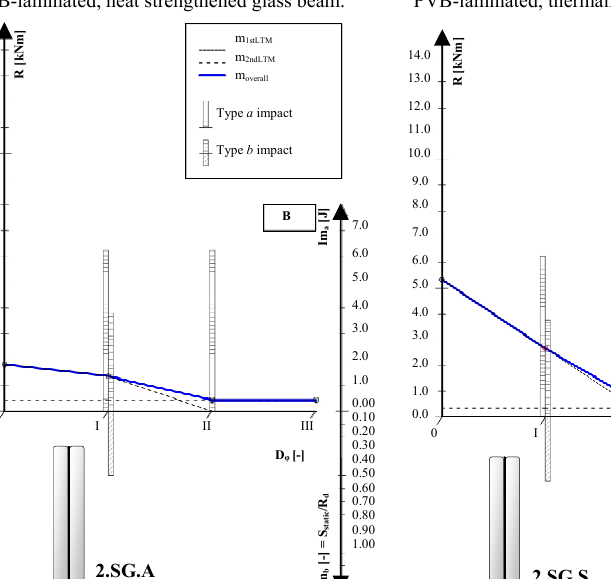
Figure 8: Element Safety Diagram for triple layer, PVB-laminated, thermally tempered glass beam.